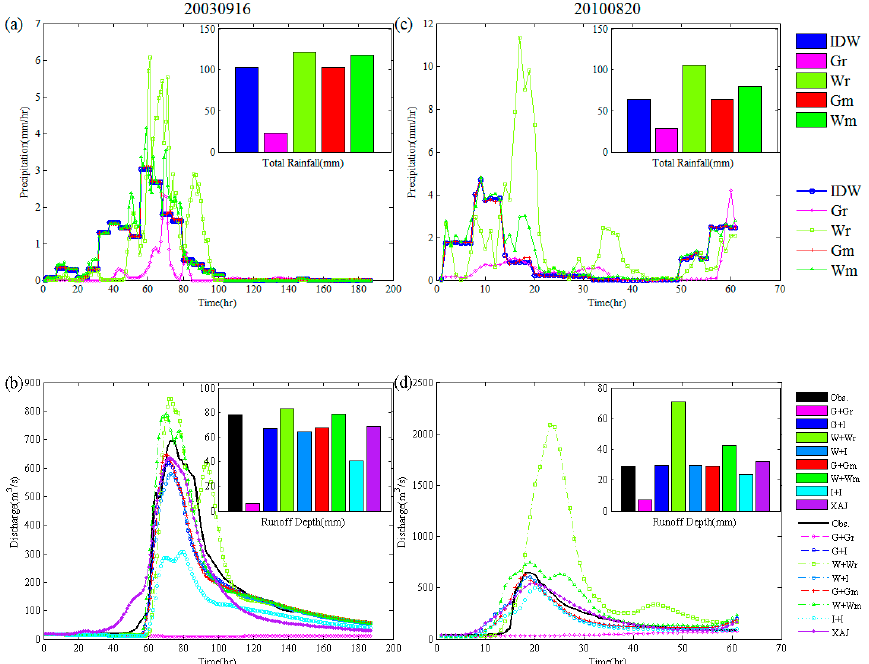
Figure 11. Hydrographs of Events 030916 and 100820, and corresponding statistics of rainfall and runoff depth, ( a ) time series of areal mean rainfall of Event 030916, ( b ) time series of discharge of Event 030916, ( c ) time series of areal mean rainfall of Event 100820, and ( d ) time series of discharge of Event 100820.